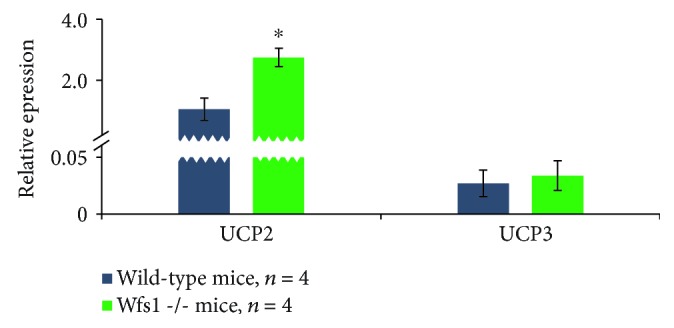
Relative expression of uncoupler proteins in homogenates of muscles in relation to housekeeping gene ACTB. ∗
P < 0.05.